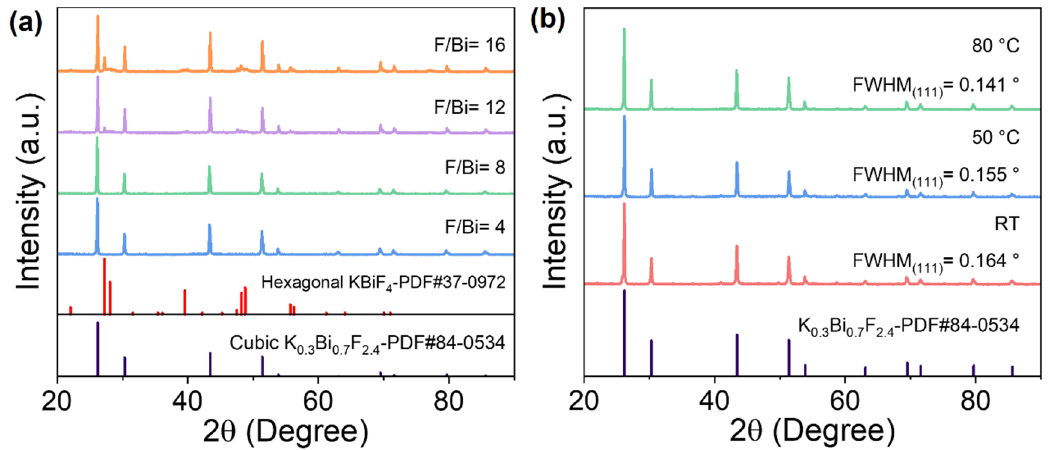
Figure 1. XRD patterns of pure KBF synthesized at different F/Bi ratios ( a ) and reaction temperatures ( b ).